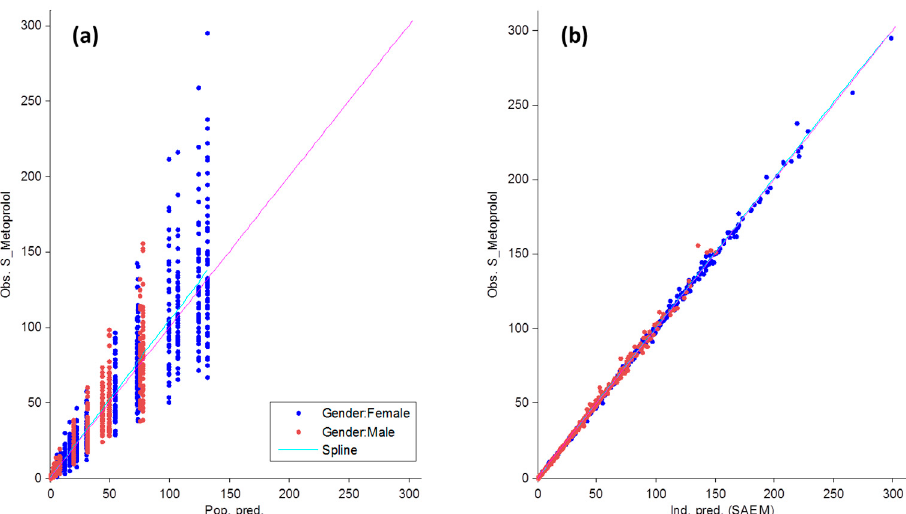
Figure 4. Goodness ‐ of ‐ fit plots for the observed versus predicted model diagnostics of the population ( a ) fit and the individual ( b ) fit of metoprolol plasma concentrations in healthy young men and women. The x ‐ axis in (a) is the population predicted plasma concentrations while the x ‐ axis on the right (b) illustrates the individual predicted concentrations based on the Stochastic Approximation Expectation–Maximization (SAEM) algorithm. The y ‐ axes are the observed metoprolol concentrations.